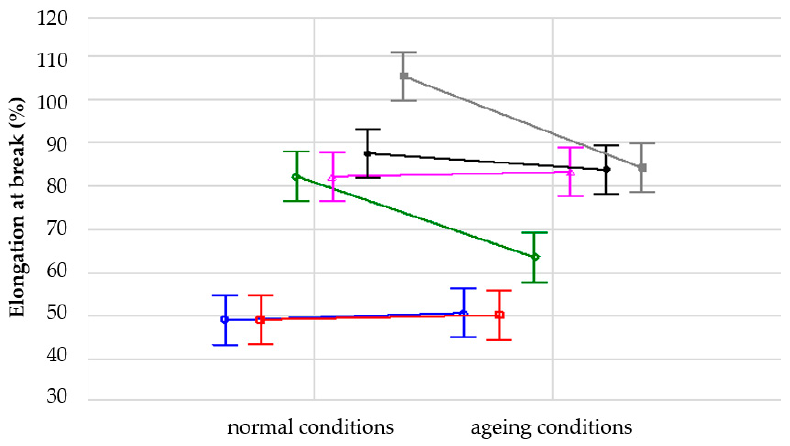
Figure 14. Influence of conditioning on elongation at break of the analyzed elastomeric materials with various densities: blue line—SBR 650, red line—SBR 700, green line—SBR 850, purple line—SBR 1000, black line—SBR 1050, grey line—SBR 1100.